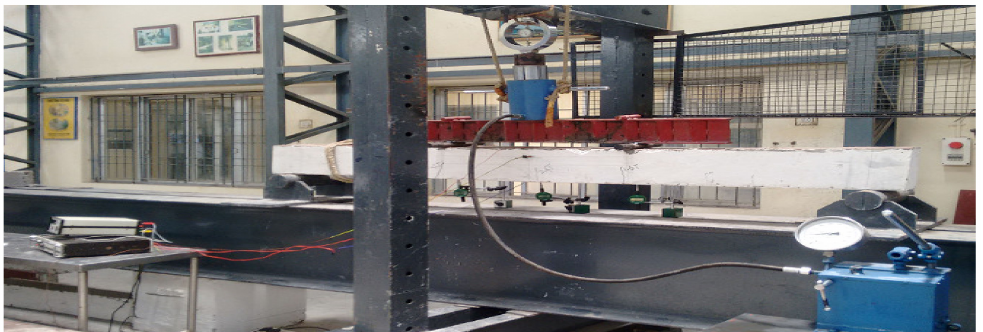
Figure 6. Schematic diagram of testing arrangement.